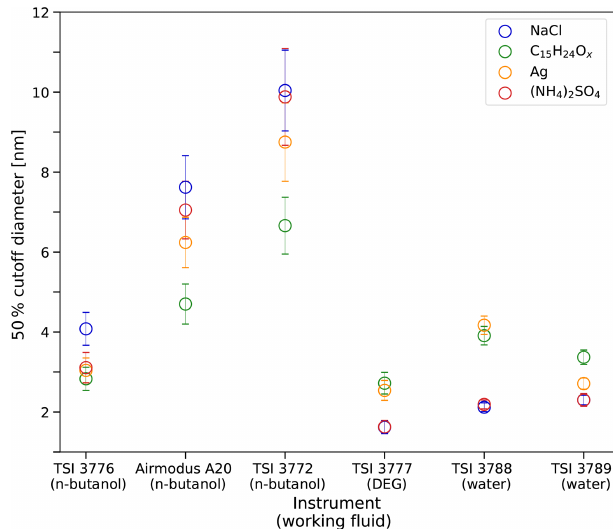
Figure 5. The 50% cutoff diameters for different working flu- ids: the figure shows the 50% cutoff diameters measured with the TSI 3776, Airmodus A20, TSI 3772, TSI 3777, TSI 3788 and TSI 3789. Different colors correspond to different seed particle compositions.